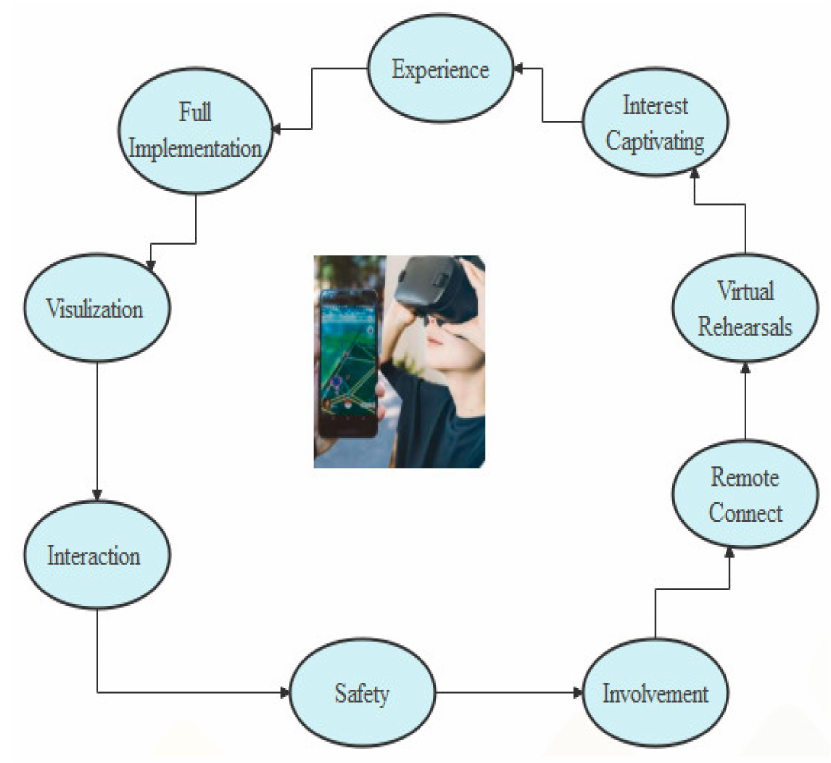
Figure 9. Graphical representation of the implementation